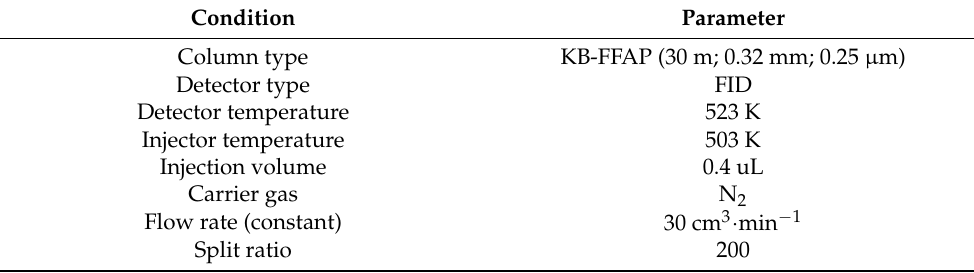
Table 3. GC conditions employed for analysis of the condensed vapor